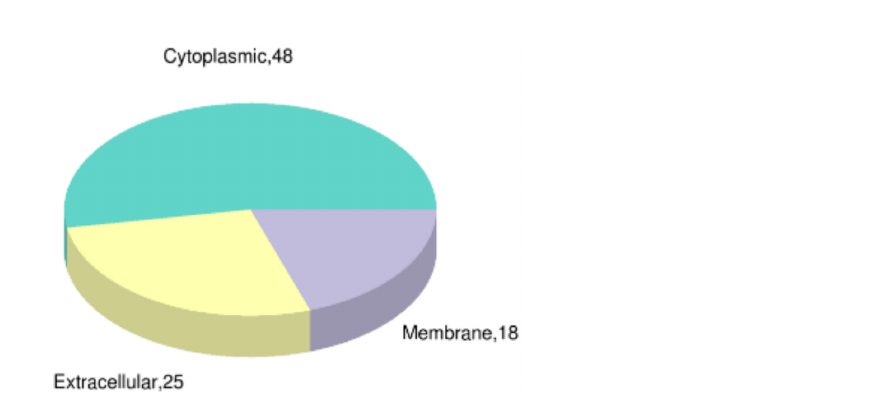
Figure 9. Subcellular localization of DEPs in B. subtilis spores after PT-LK